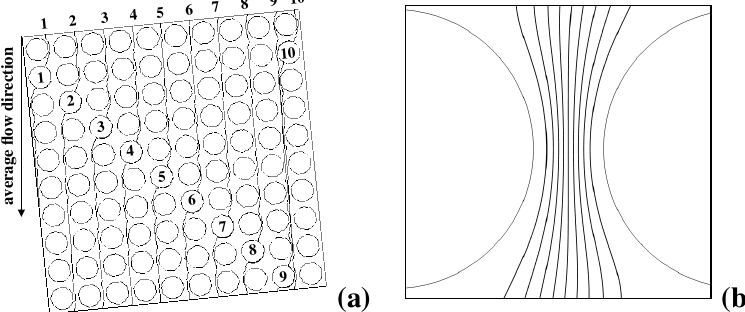
Figure 4. Kinematic structure of the pressure-driven Stokes flow in Huang’s prototype. ( a ) critical streamlines associated with selected obstacles (numbered from 1 to 10) in a 10 × 10 area of the lattice; note that each streamline enter and leaves the area at the same horizontal coordinate, its average direction being parallel to the channel walls (collinear with the average flow direction); ( b ) structure of the flux tubes (lanes) associated with critical streamlines in the restricted gap between adjacent